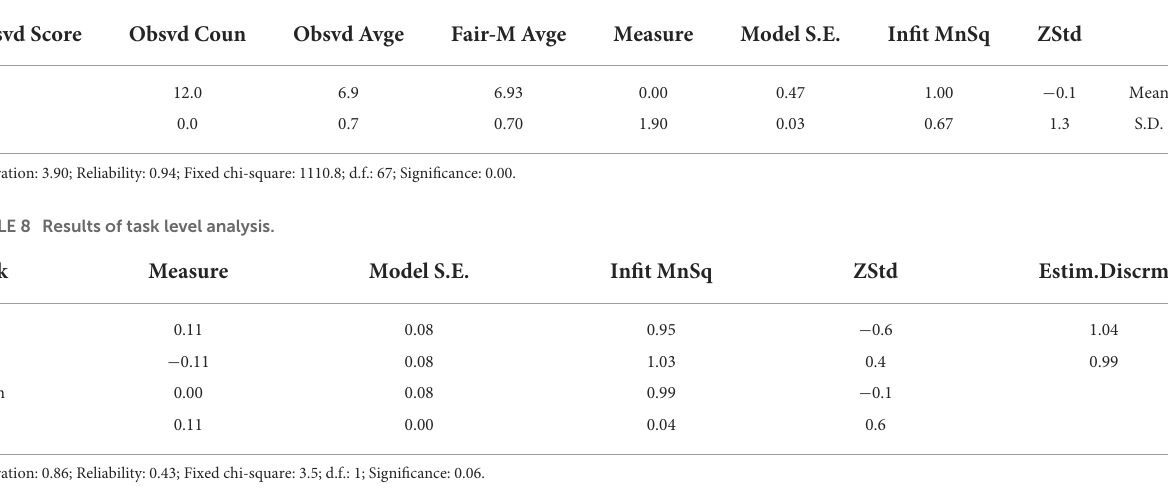
TABLE 7 Results of examinee level analysis.